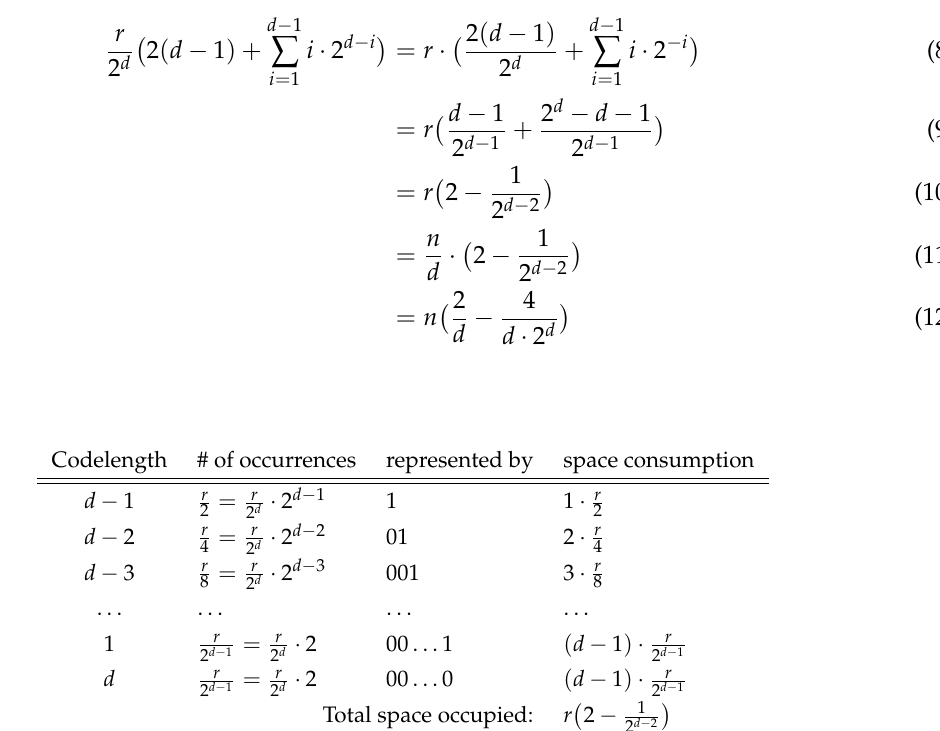
Figure 2. The optimal prefix-free codes for the code-word lengths are then { 1, 01, 001, . . . , 0 d − 2 1, 0 d − 1 } , which correspond to code-word lengths { d − 1, d − 2, d − 3, . . . , 1, d } respectively. Thus, code-word · 2 d − i times on A , can be shown by i bits. length (cid:96) = ( d − i ) ∈ { 1, 2, . . . , d − 1 } , which appears r 2 d